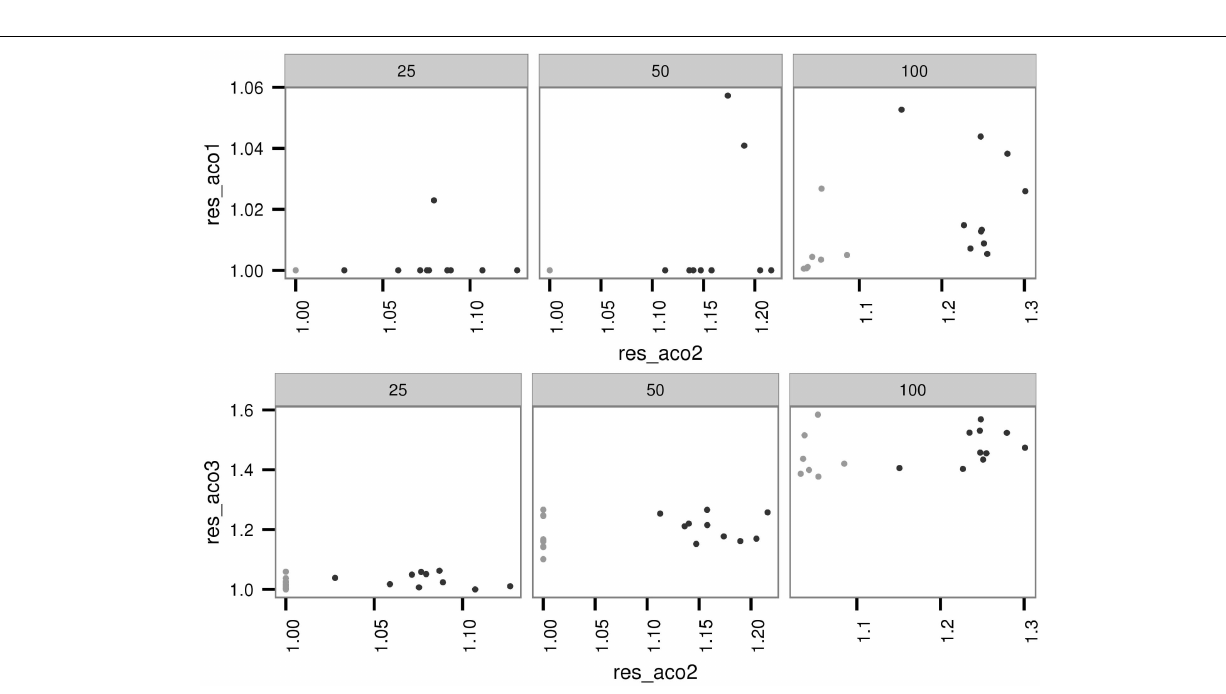
and n among feasible values. For one batch of instances, we keep the (cid:26) fixed to 0.5 and evolved instances for three n val- ues 5, 25, and 100, whereas in the other batch n is kept fixed to 25 and (cid:26) is varied among 0.2, 0.5, and 0.8. The general